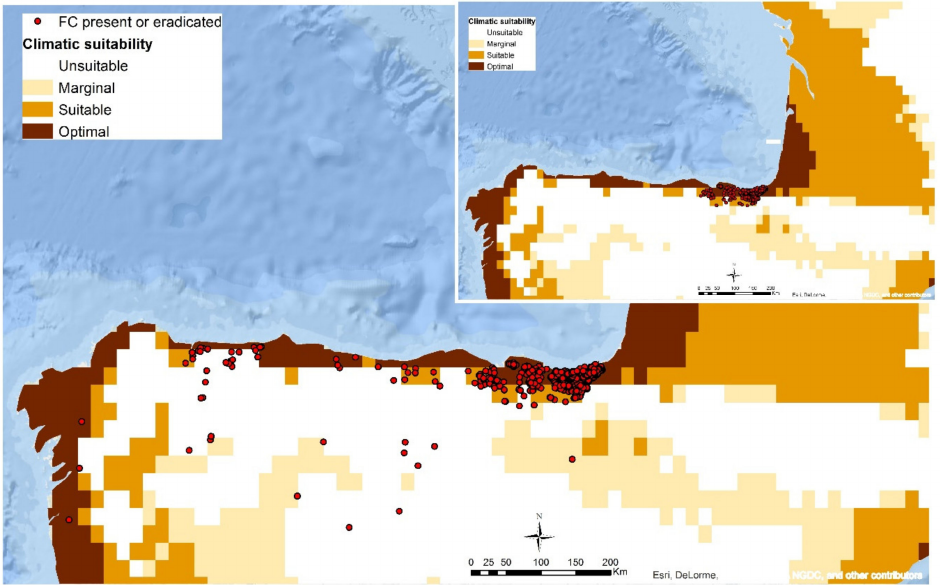
Figure 3. Climatic suitability for Fusarium circinatum based on the CLIMEX model parameters of Ganley et al. [28] using higher resolution climatic data [133] focused on the current European outbreak